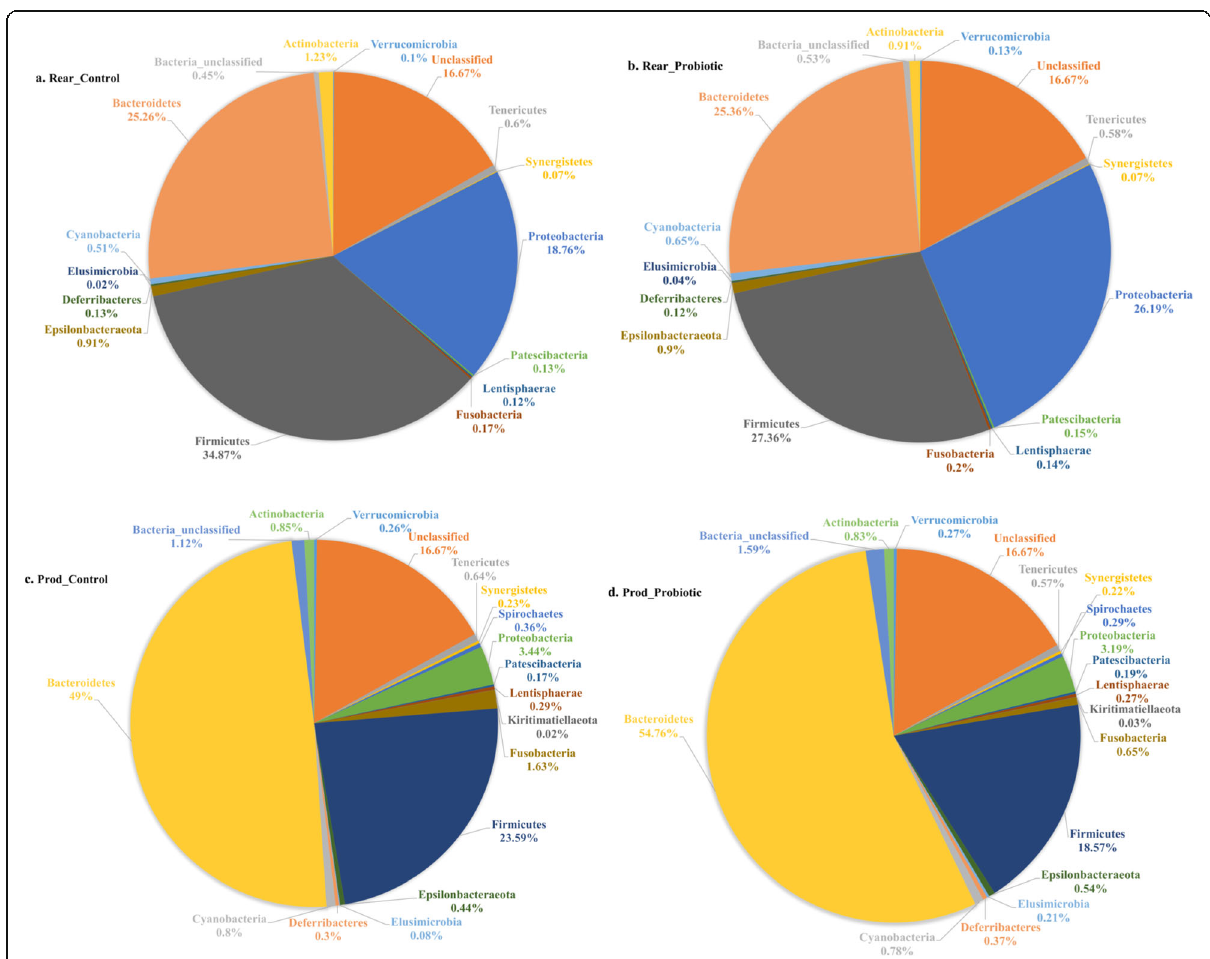
Fig. 2 Overall gut microbiota composition at phylum level affected by probiotic supplementation in rearing and production phases of hens. a ). Microbial abundance (%) of the control flock (Rear_Control) in the rearing phase. b ). Microbial abundance (%) of the probiotic flock (Rear_Probiotic) in the rearing phase. c ). Microbial abundance (%) of the control flock (Prod_Control) in the production phase. d ). Microbial abundance (%) of the probiotic flock (Prod_Probiotic) in the production phase. For percent calculation of microbial abundance at the phylum level, total sum scaling normalised but untransformed data obtained from Calypso software were visualised in Excel 2016 and the panel graphs were prepared in Graphpad prism v.